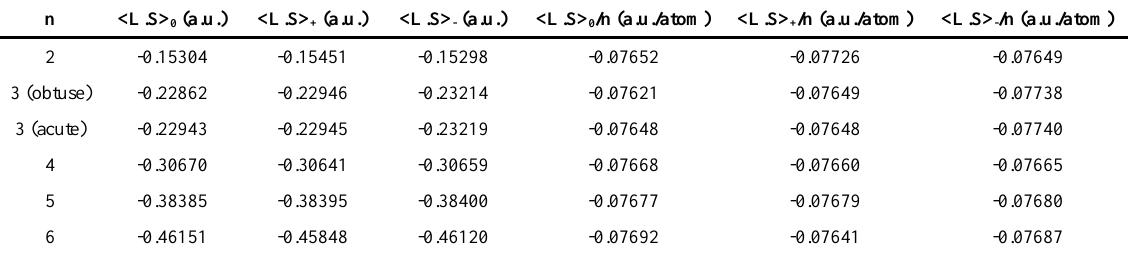
Table 7. Spin-orbit coupling energies of the neutral <L.S> 0 , cationic <L.S> + , and anionic <L.S> - gold clusters at the DKH2- B3P86/DZP-DKH//DKHSO-GHF/DZP-DKH level. The SOC energies of the cationic and anionic clusters are at the optimized geometries of neutral clusters.